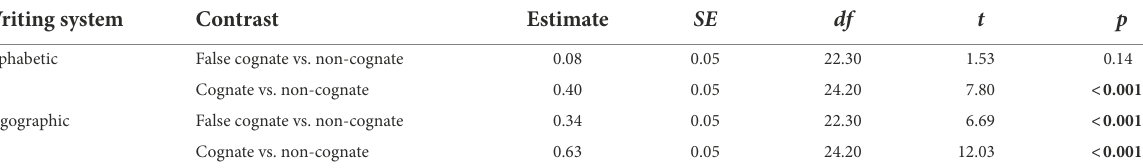
TABLE 4 Simple effects in the production tasks.